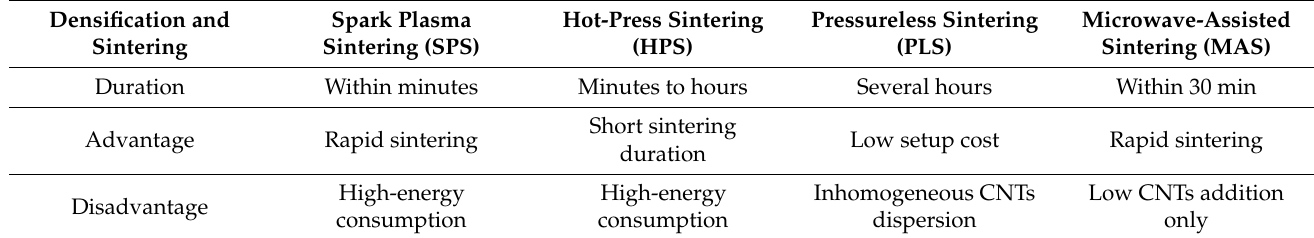
Table 13. Comparison table of the densification and sintering